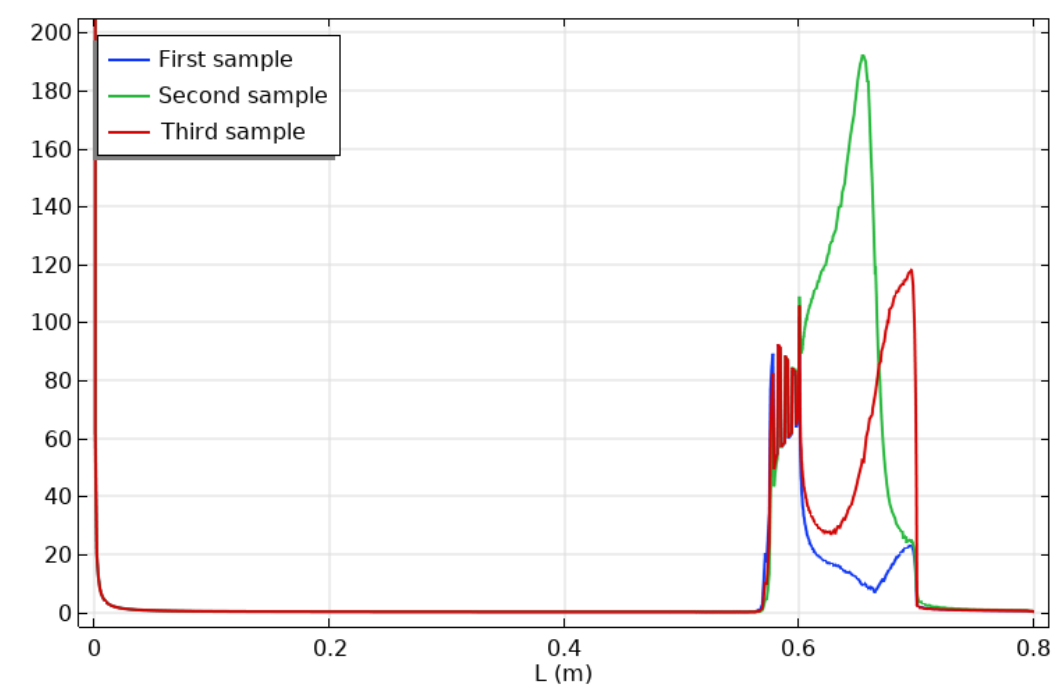
Figure 16. Local temperature in the channel–enclosure assembly .